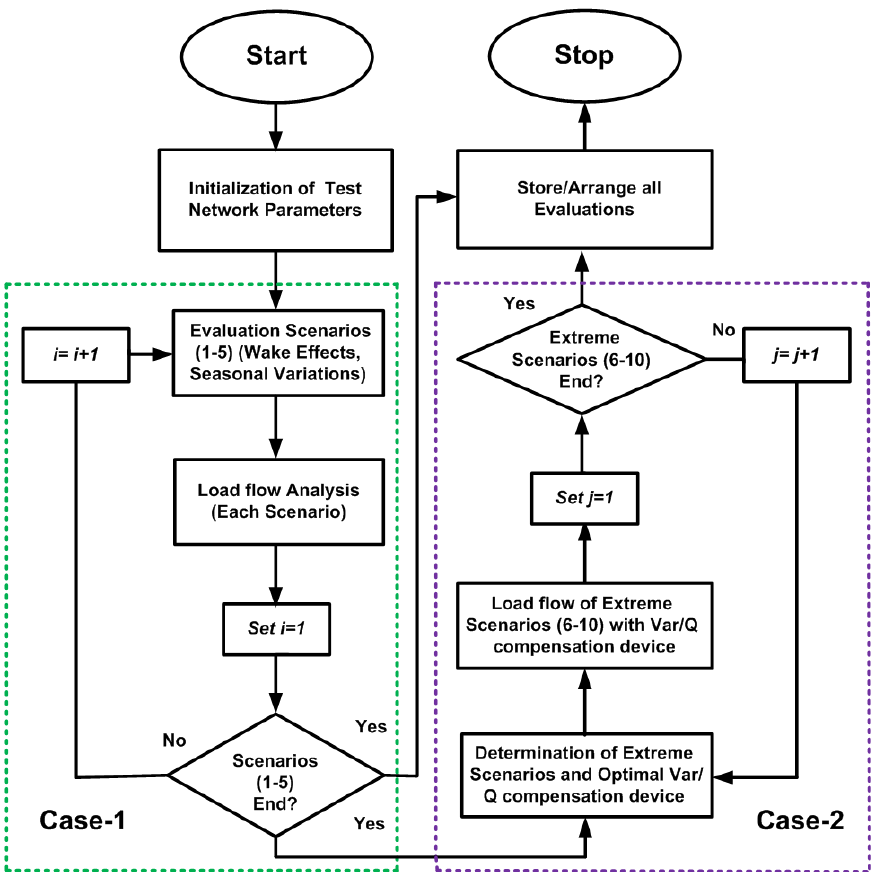
Figure 3. Flow chart of the proposed methodology.